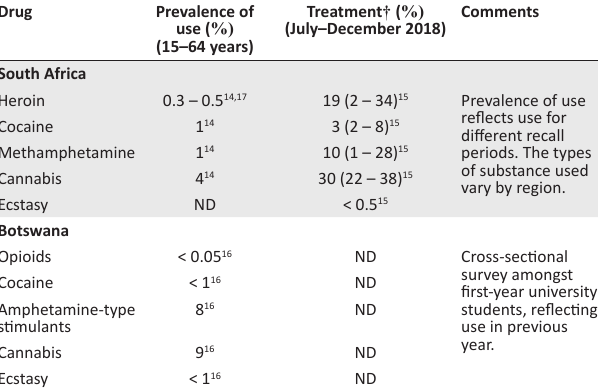
TABLE 3: Overview of substance use epidemiology (latest data). 14,15,16,17